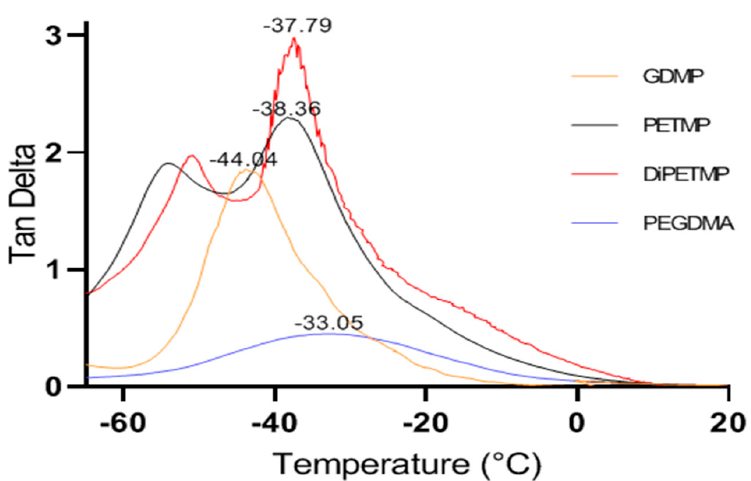
Figure 10. Dynamic mechanical analysis results showing tan delta for the PEGDMA and PEGDMA-thiol samples post polymerization.